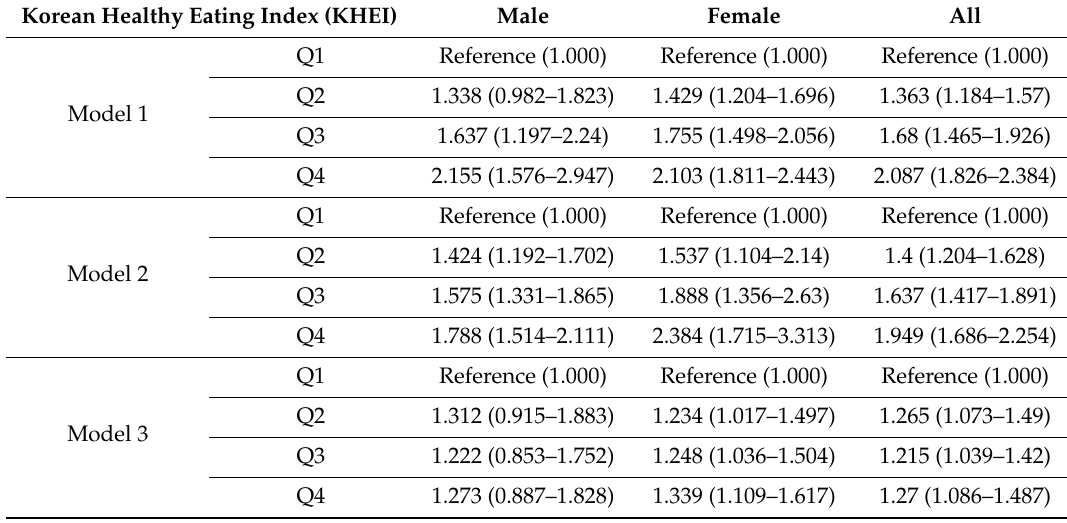
Table4. Adjustedoddsratios(95%confidenceintervals)forhavinghealthyestimatedcardiovascularage (cardiovascular age < chronological age) after adjustments for